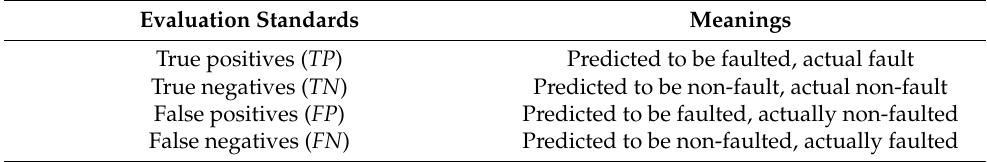
Table 1. Four prediction scenarios for fault